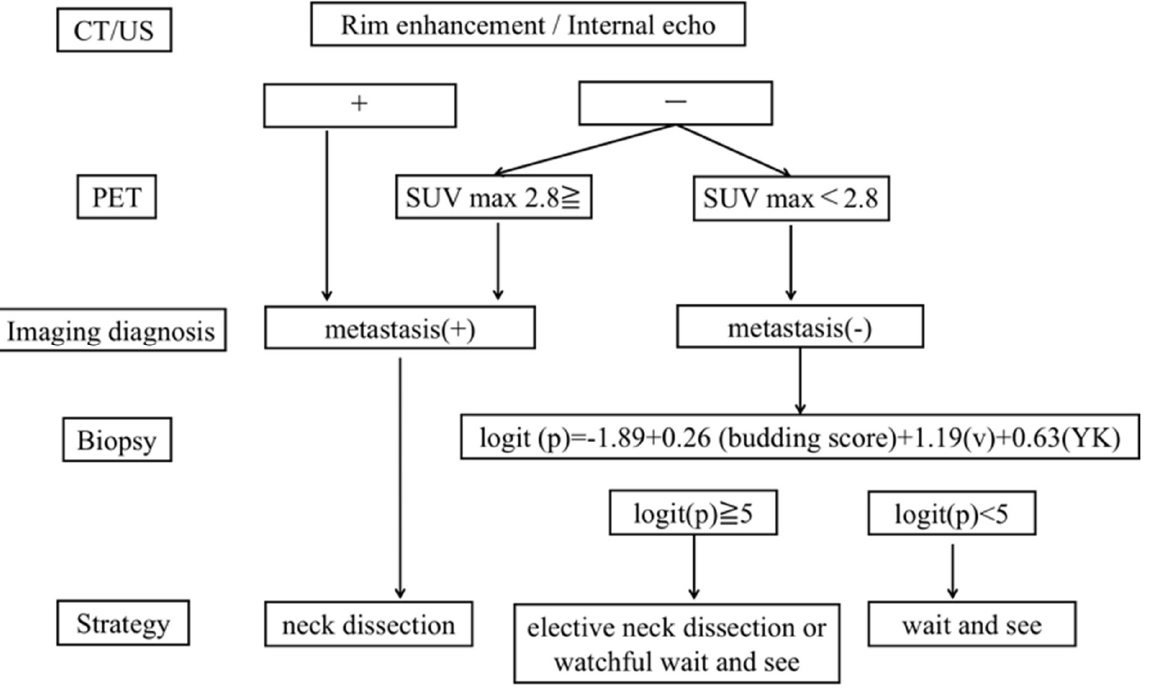
Figure 3. Diagnostic criteria and therapeutic strategy combining preoperative imaging and pathological findings for lymph node metastasis of oral squamous cell carcinoma.